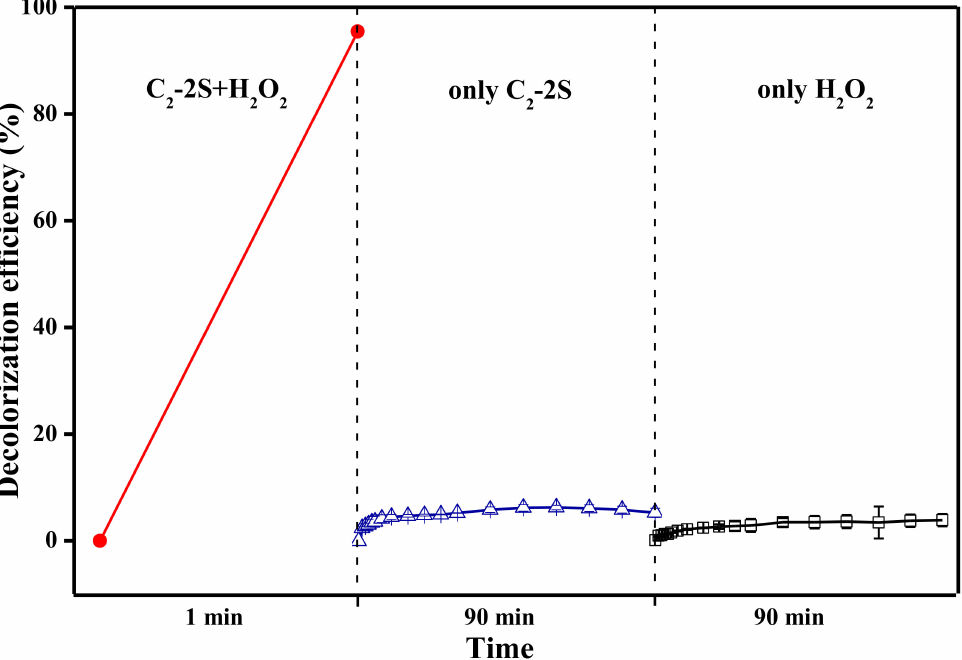
Figure 11. MB decolorization efficiency of different systems; the left shows the system including MB aqueous solution, H 2 O 2 , and fiber C 2 -2S; the middle shows the system including MB aqueous solution and fiber C 2 -2S; the right shows the system including MB aqueous solution and H 2 O 2 ; fiber C 2 -2S is defined in Section 2.4.